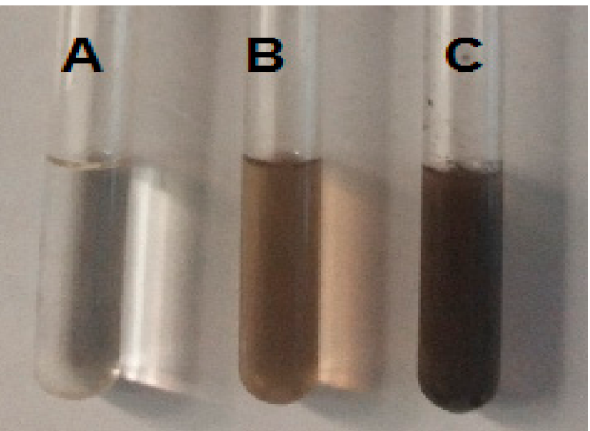
Figure 1. ( A ) AgNO 3 aq. solution; ( B ) Aq. roots extract of Z. armatum ; ( C ) AgNPs